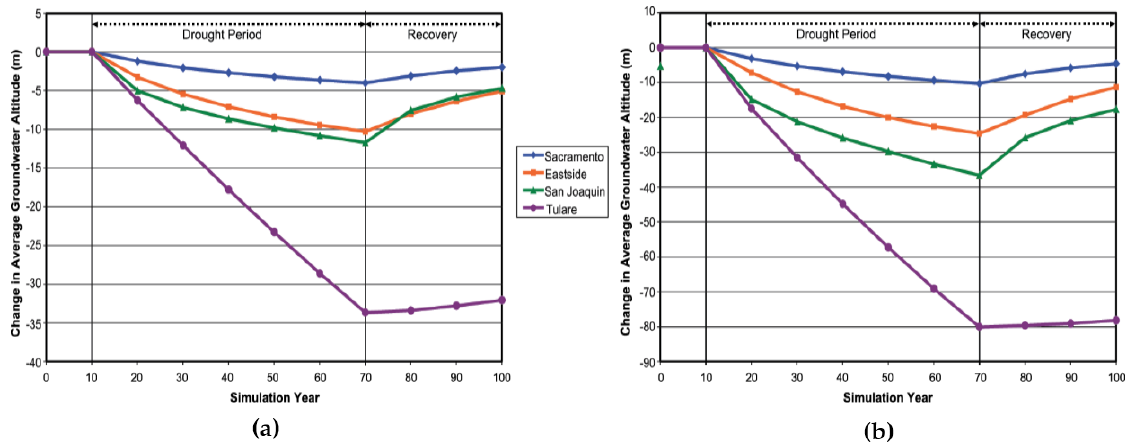
Figure 5. Change in average groundwater heads across the Valley for ( a ) slight 60 ‐ year drought and ( b ) severe 60 ‐ year drought (source: Miller et al. [48])